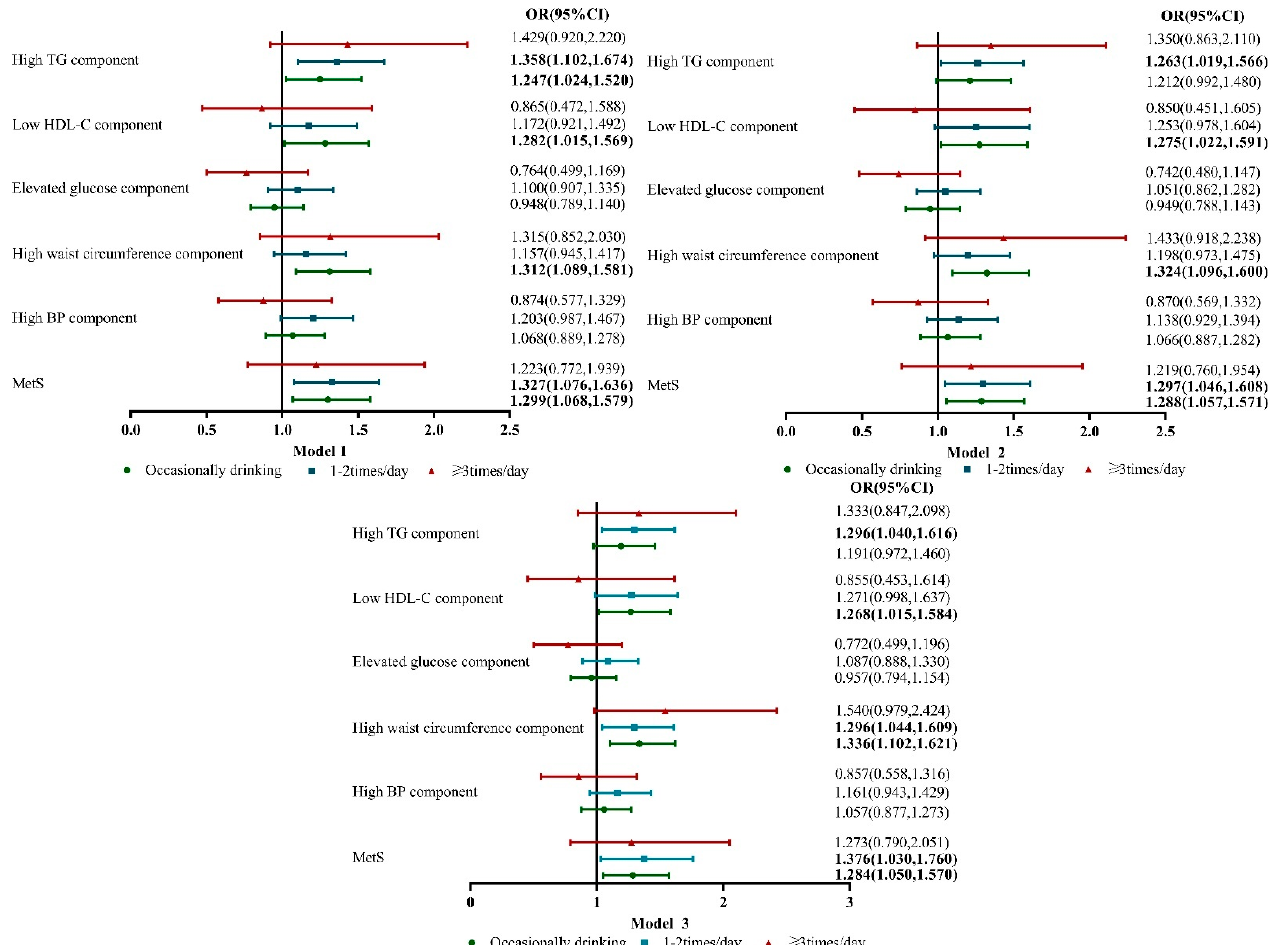
Figure 2. Multivariate logistic regression analysis estimated the possible relationship between tea consumption and metabolic disorders, adjusting for possible confounders. Model 1 adjusted for age and gender. Model 2 adjusted for factors included in Model 1 plus ethnicity, current drinking and smoking status, marriage status, educational status, sleep duration, annual income, and physical activity. Model 3 adjusted for factors included in Model 2 plus BMI, eGFR, uric acid, AST/ALT and diet scores.